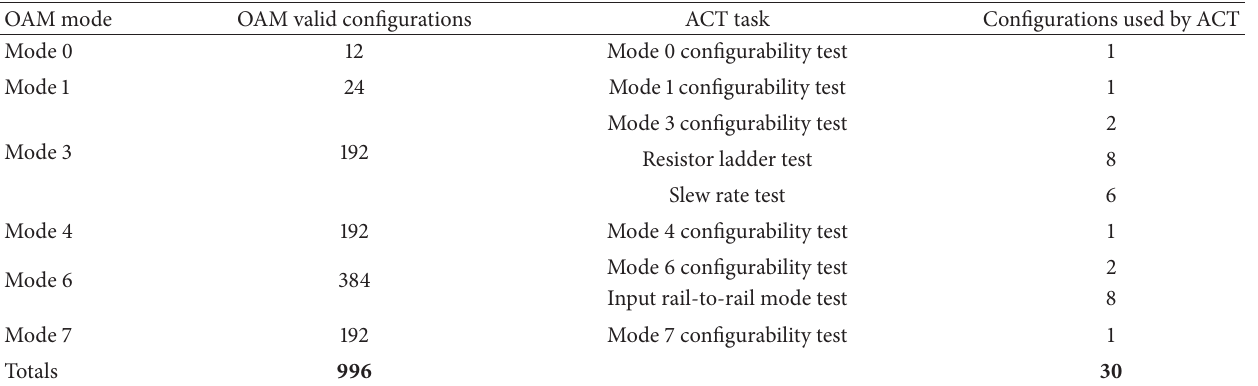
Table 2: OAM valid configurations versus used by